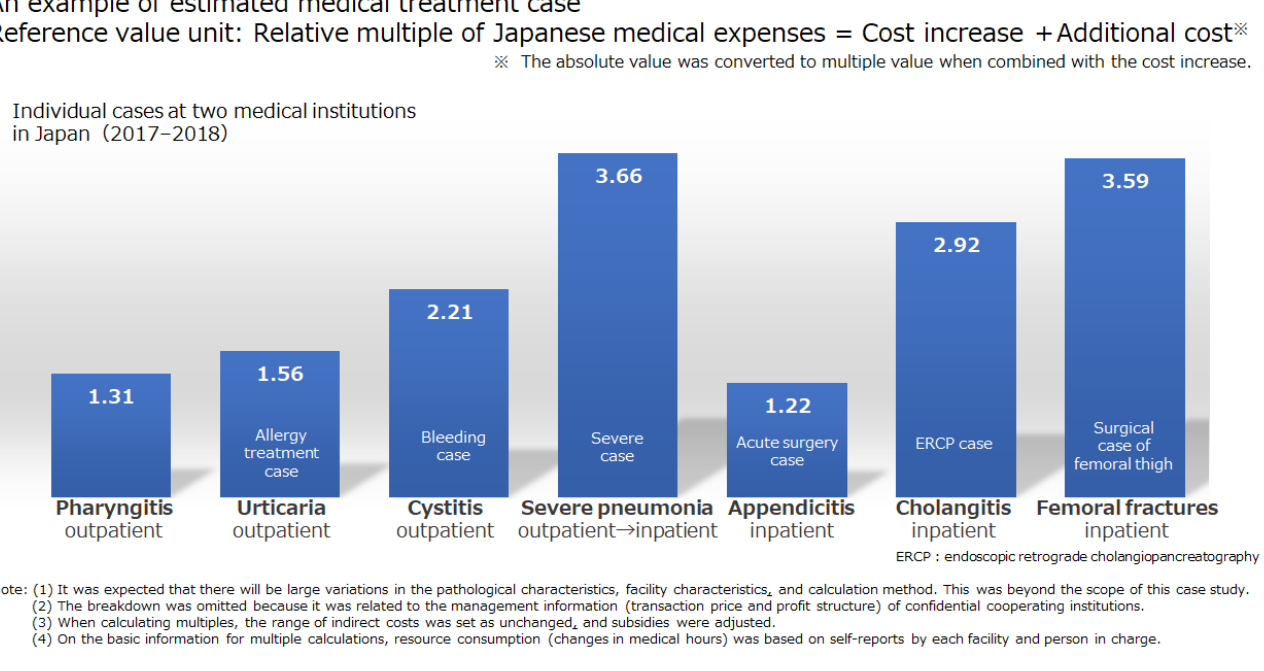
Figure 4. Calculation of price levels for foreign visitors (seven